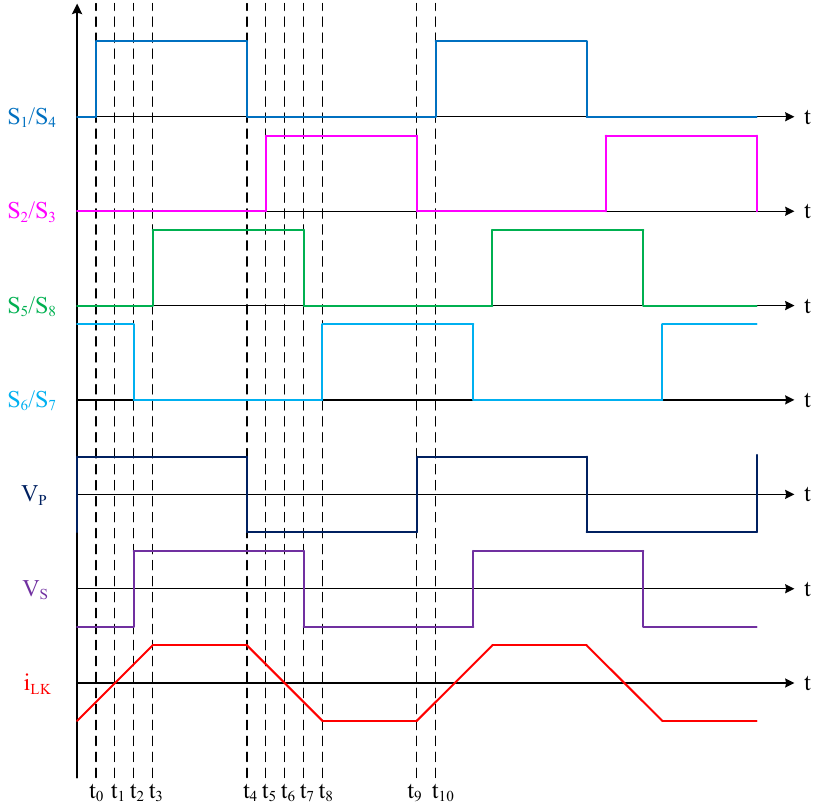
Figure 7. Theoretical waveforms of the proposed control strategy for the DAB converter in SPS mode under medium-to-full load conditions.